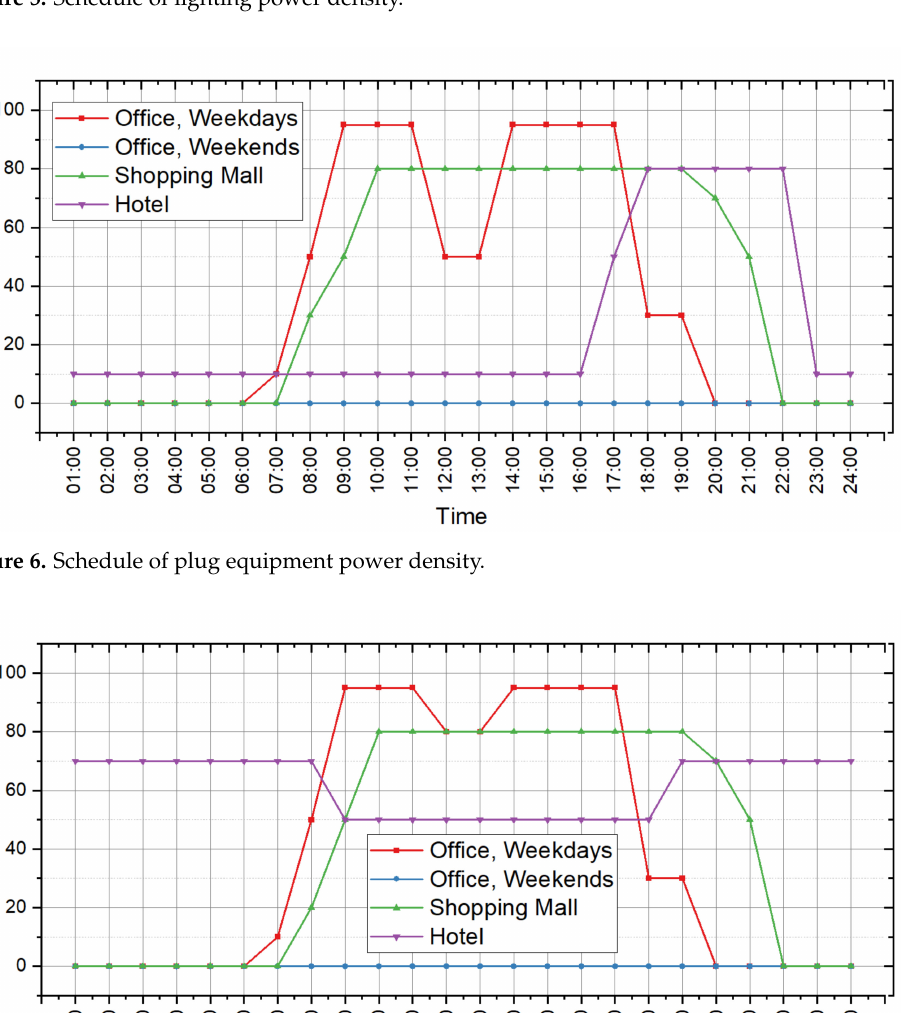
Figure 5. Schedule of lighting power density.